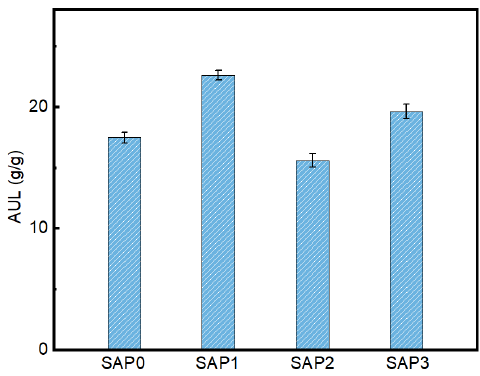
Figure 6. AUL of SAP0, SAP1, SAP2, and SAP3.